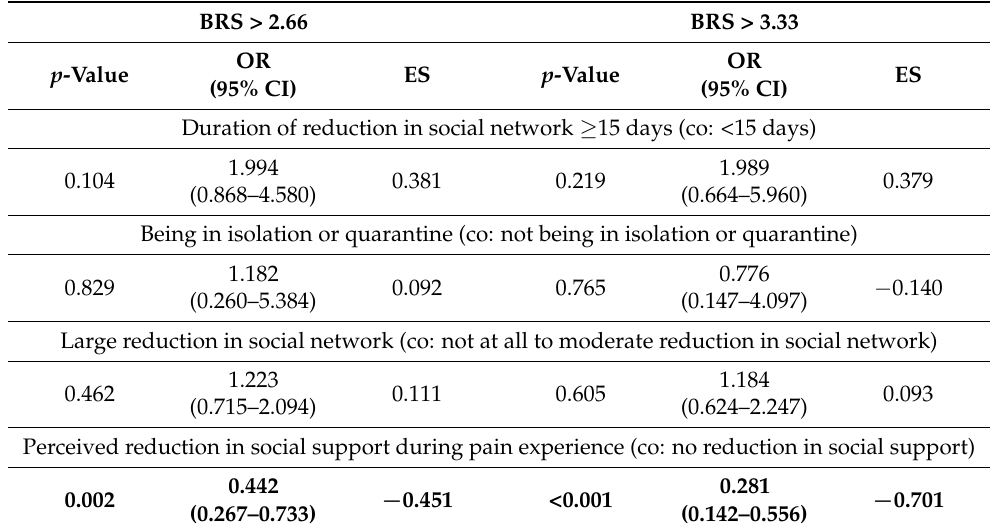
Table 3. Influence of pandemic-specific factors on resilience (univariate logistic regression analysis). BRS > 2.66 BRS >